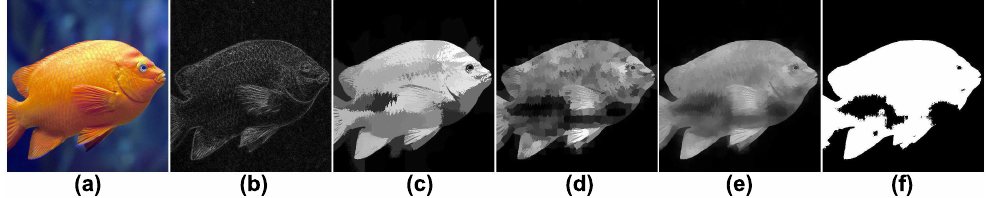
Figure 6. Sharpness estimation process. ( a ) original image, ( b ) Aydin’s clearness map, ( c ) sharpness distribution at level 2, ( d ) sharpness distribution at level 5, ( e ) sharpness map, ( f ) in-focus